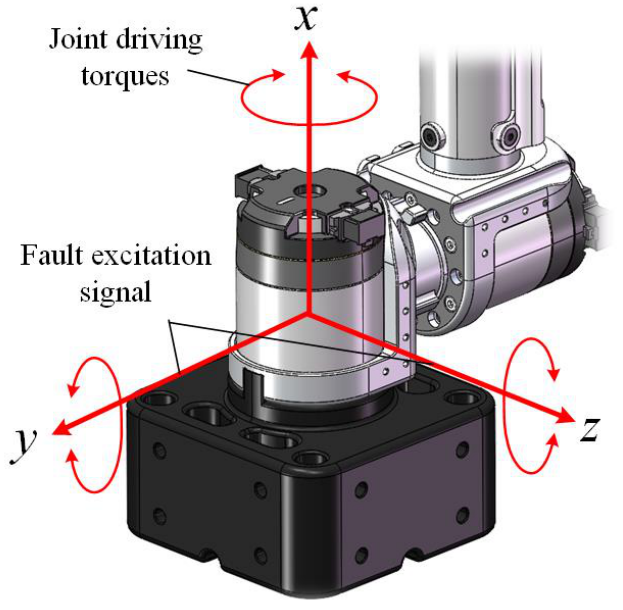
Figure 8. Diagram of the general force set in robot joint.